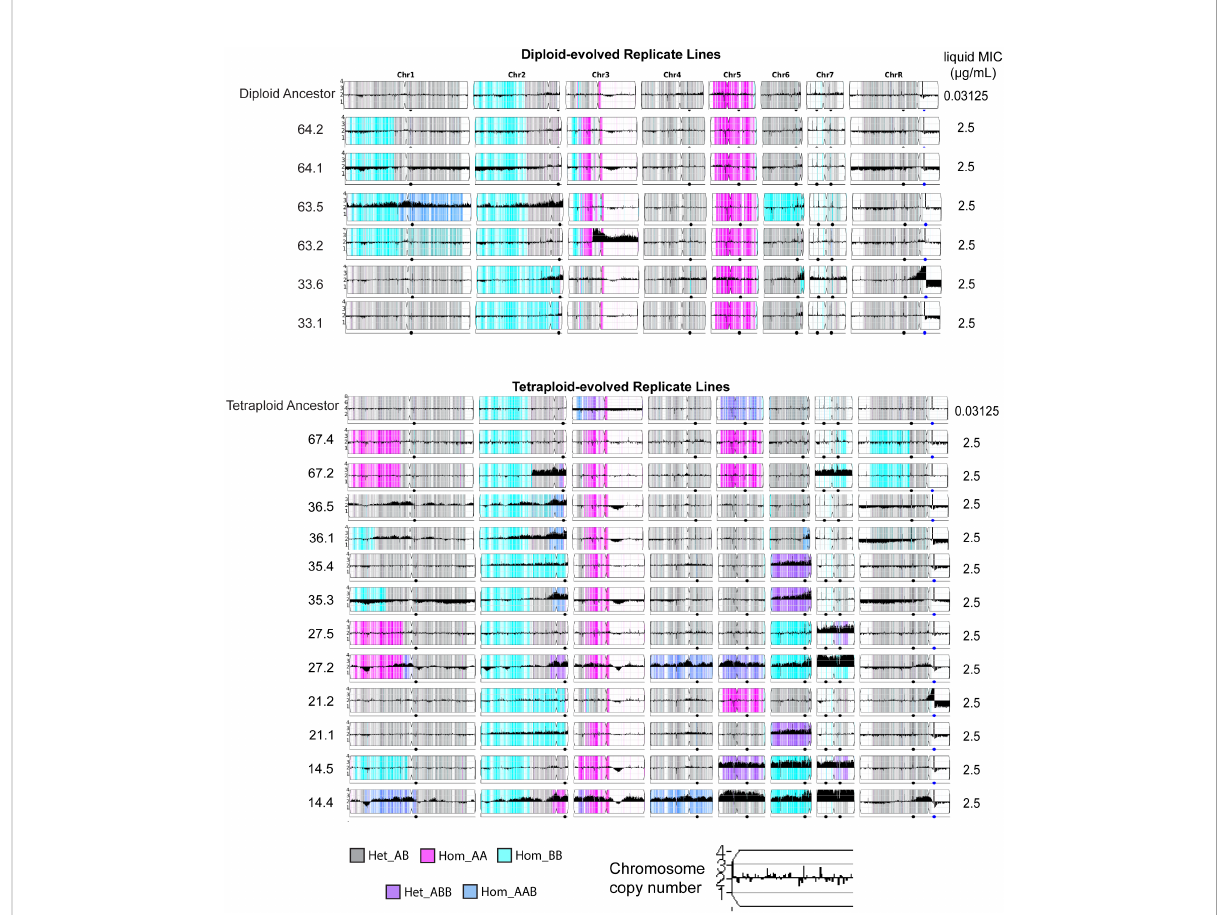
FIGURE 3 Genome-wide changes following evolution in caspofungin. YMAPs of C.albicans diploid (top) and tetraploid-evolved (bottom) isolates on day59 of evolution in caspofungin. Reference diploid and reference tetraploid are displayed at the top of each respective sections. Two single colonies (isolates) were sequenced is per replicate line. Chromosome copy number is indicated on each chromosome and chromosomal color indicates allelic ratio (gray = heterozygous, cyan/pink = homozygous, darker blue/purple = heterozygous with >2 alleles). MIC on day59 is shown on the right of each